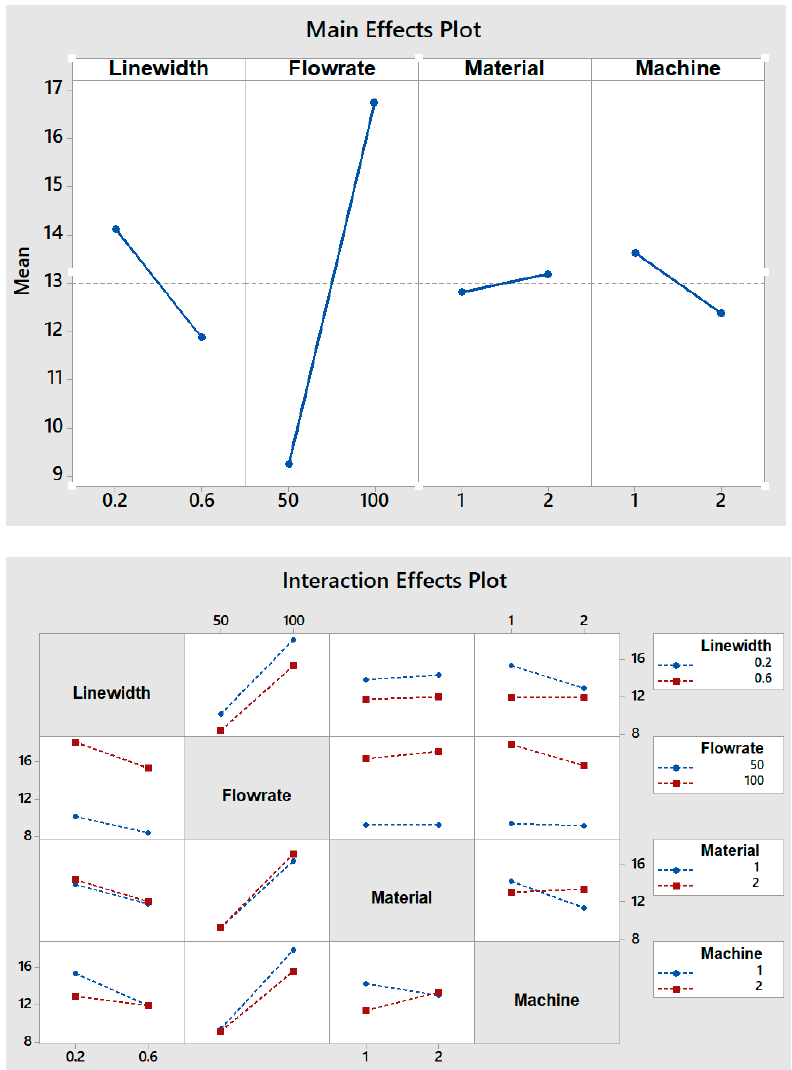
Figure 5. Main and interaction effects plots for the length of mixing.